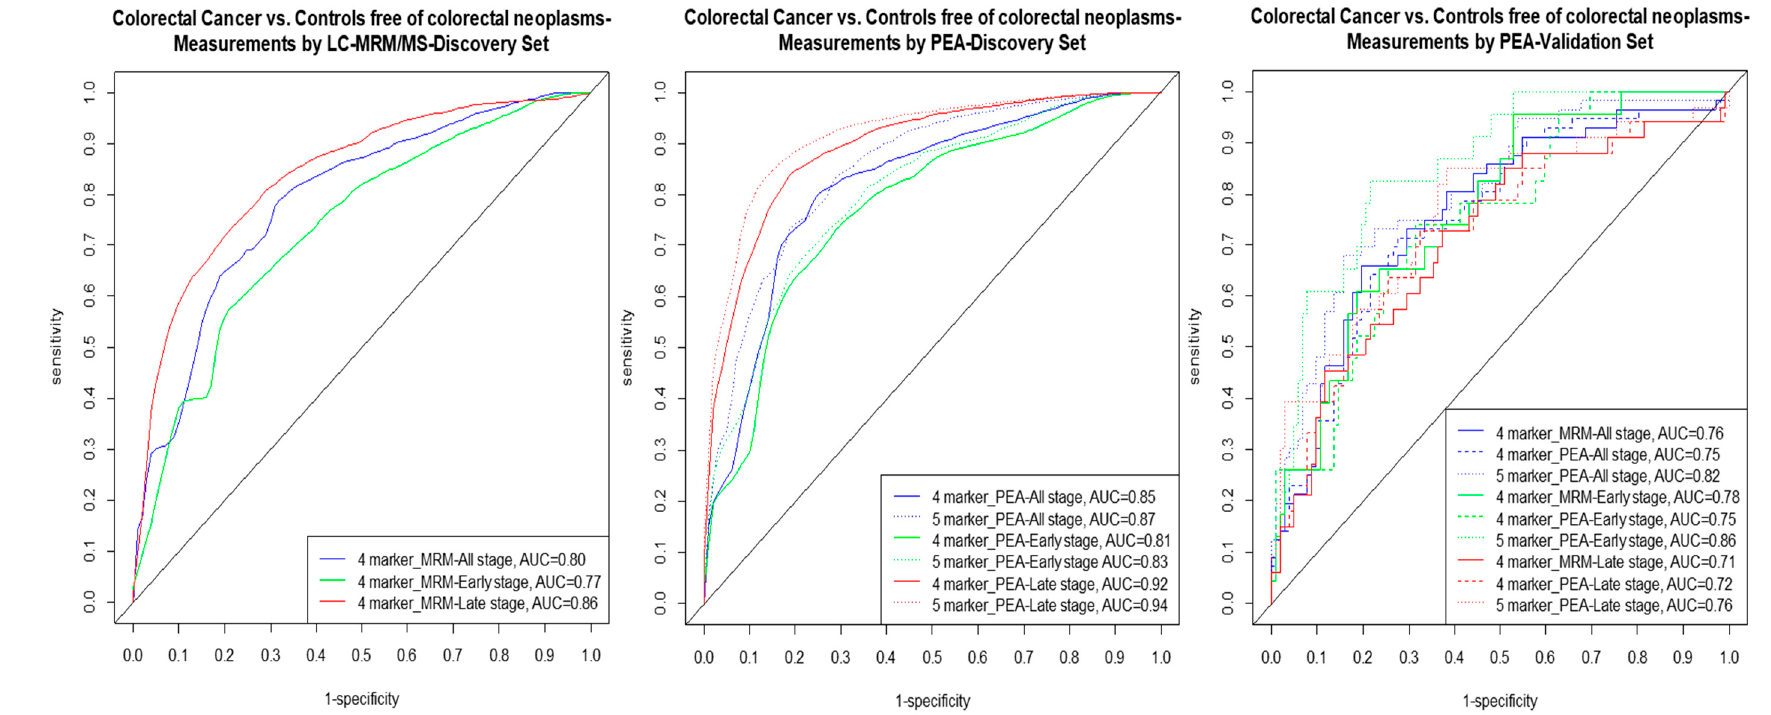
Figure 1. Comparison of the ROC curves for detecting (all/early/late) stage CRC vs. free of neoplasm controls with four and five-marker signatures. Abbreviations: AUC—area under the ROC curve; CRC—colorectal cancer; LC/MRM-MS—liquid chromatography/multiple reaction monitoring-mass spectrometry; PEA—proximity extension assay; ROC—receiver operating characteristics.